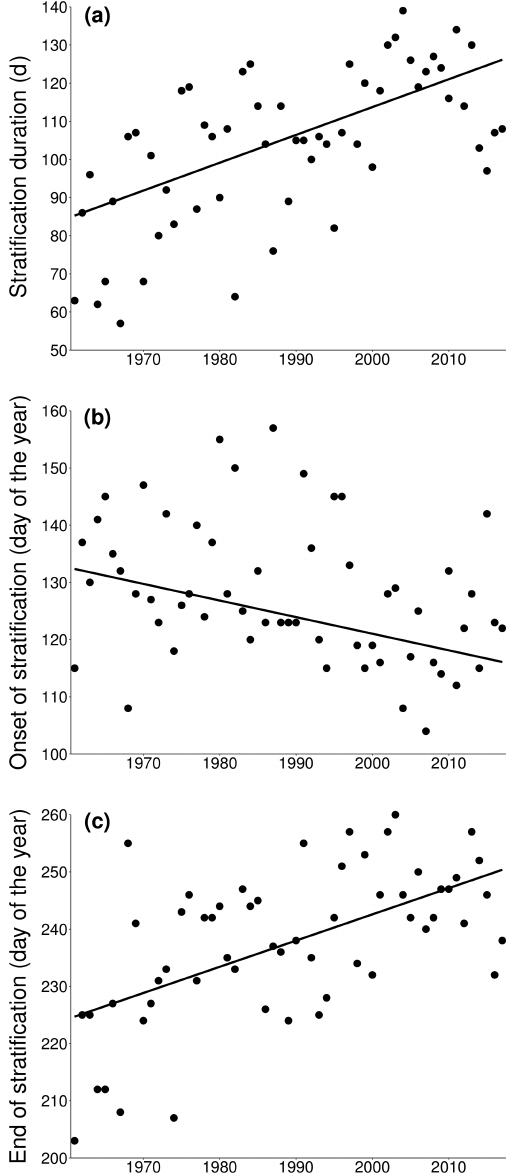
Figure 8. Reconstructed stratification duration (a) , onset (b) , and termination (c) of Lake Erken between 1961 and 2017. Stratifica- tion duration trend: 7.297d per decade ( p < 0 . 001). Onset of strati- fication trend: − 2 . 903d per decade ( p < 0 . 01). End of stratification trend: 4.583d per decade ( p < 0 . 001).